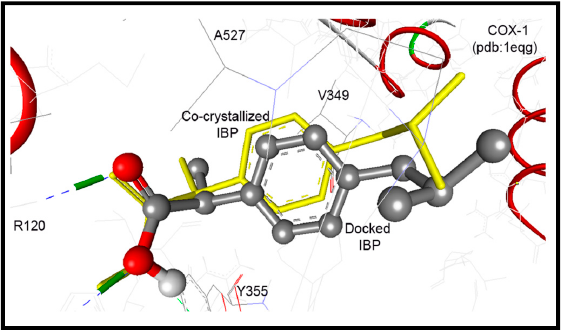
Figure 8. Ibuprofen docked superimposed onto the position of co-crystalized ligand within RMSD of